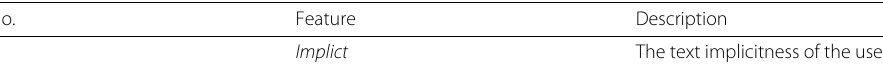
Table 3 Improved text implicitness